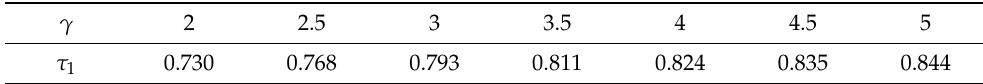
Table 1. Maximum allowable τ 1 for different γ by Theorem